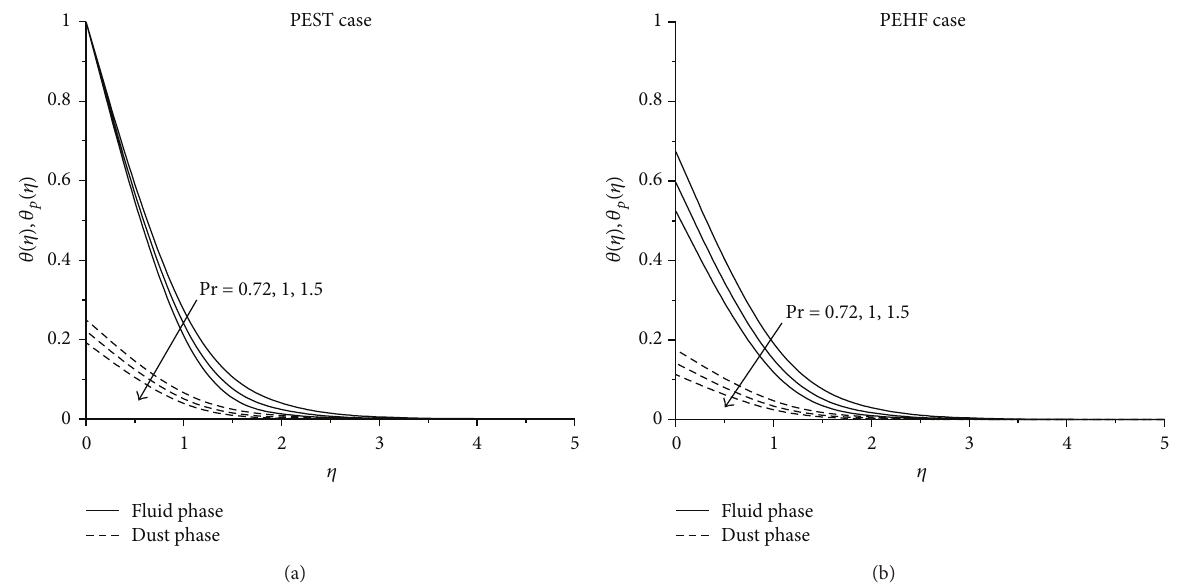
Figure 8: Effect of Pr on temperature profiles for both PEST and PEHF cases with 𝑆 = Ec = 𝑁 = 𝜆 = 0.5 and 𝛽 = 0.6 .